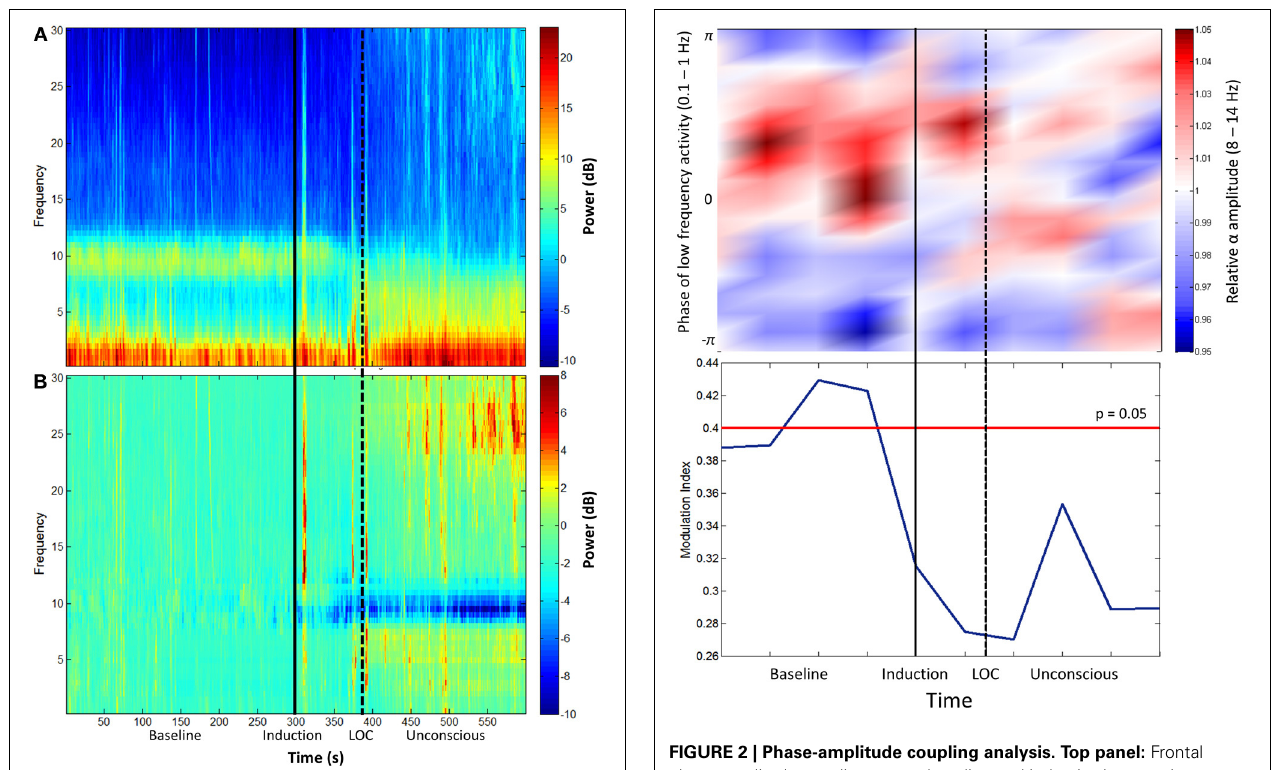
FIGURE 2 | Phase-amplitude coupling analysis. Top panel: Frontal phase-amplitude coupling across baseline and induction/unconscious epochs. Bottom panel : Modulation indices (blue line) of each minute of data in baseline and induction/unconscious epochs; values are significant at p = 0 . 05 above the red line. LOC, loss of